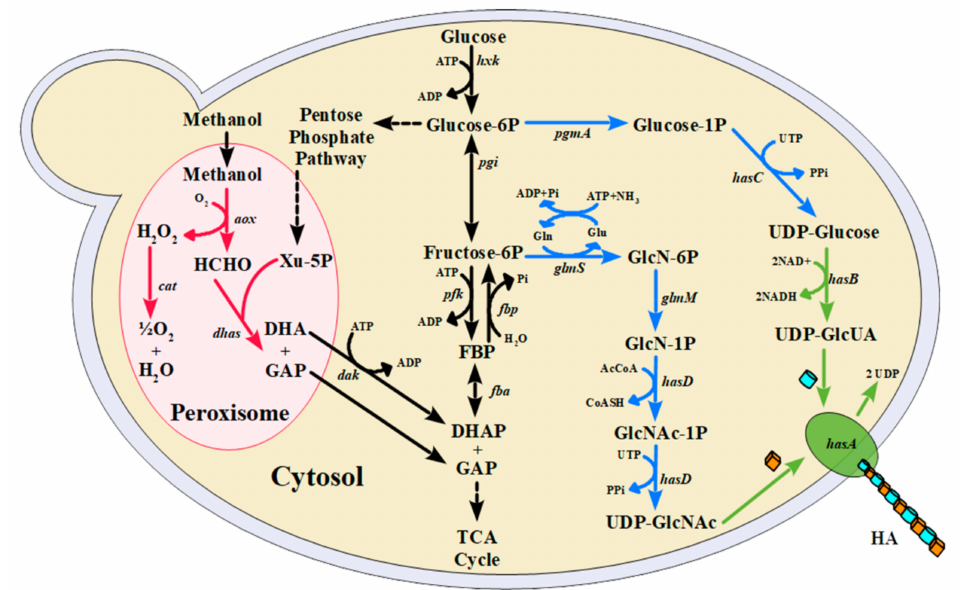
Figure 1. Biosynthetic pathway for hyaluronic acid (HA) production in Ogataea ( Hansenula ) polymorpha . The black and blue arrows indicate the endogenous glycolysis and HA precursor pathways, respectively. The green arrows indicate the exogenous pathway inserted in O. polymorpha for HA production. The red arrows represent methanol metabolism. Genes encoding enzymes of the pathways are shown: aox : alcohol oxidase; cat : catalase; dhas : dihydroxyacetone synthase; dak